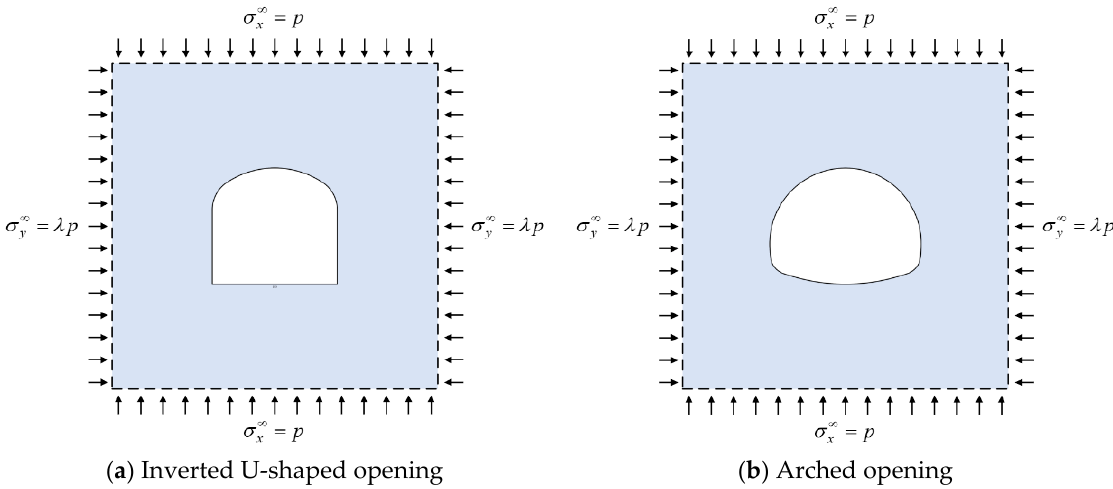
Figure 8. Schematic diagram of a plate containing an opening under far-field stress condition.